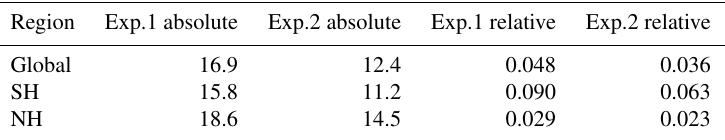
Table 2. Global and hemispheric means of the CCN sensitivity to the flux DMS (as defined by Woodhouse et al., 2010, 2013) in both absolute (cm − 3 /mgm − 2 day − 1 ) and relative terms, for Exp.1 and